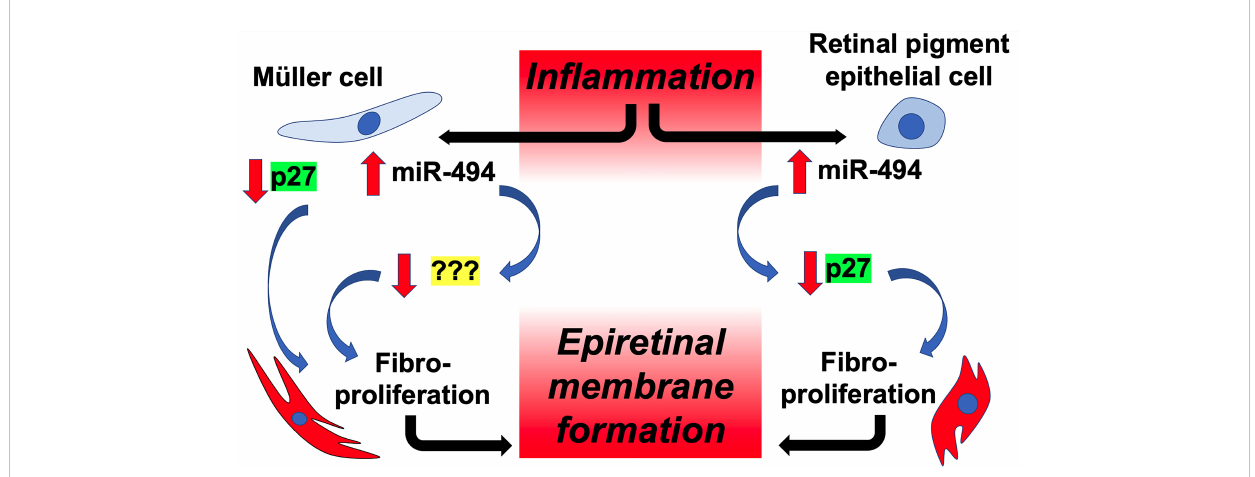
FIGURE 5 Proposed model of cell-type speci fi c targeting of p27 by miR-494 in ERM fi brotic transformation. Microglial-mediated in fl ammation triggers elevations in miR-494 expression in both Müller cells and RPEs, leading to downstream fi brotic transformation in both cell types, and ultimately to ERM formation. Although decreases in p27 play a central role in fi brotic transformation in both cell types, only in RPE cells is reduced expression of p27 due to direct targeting by